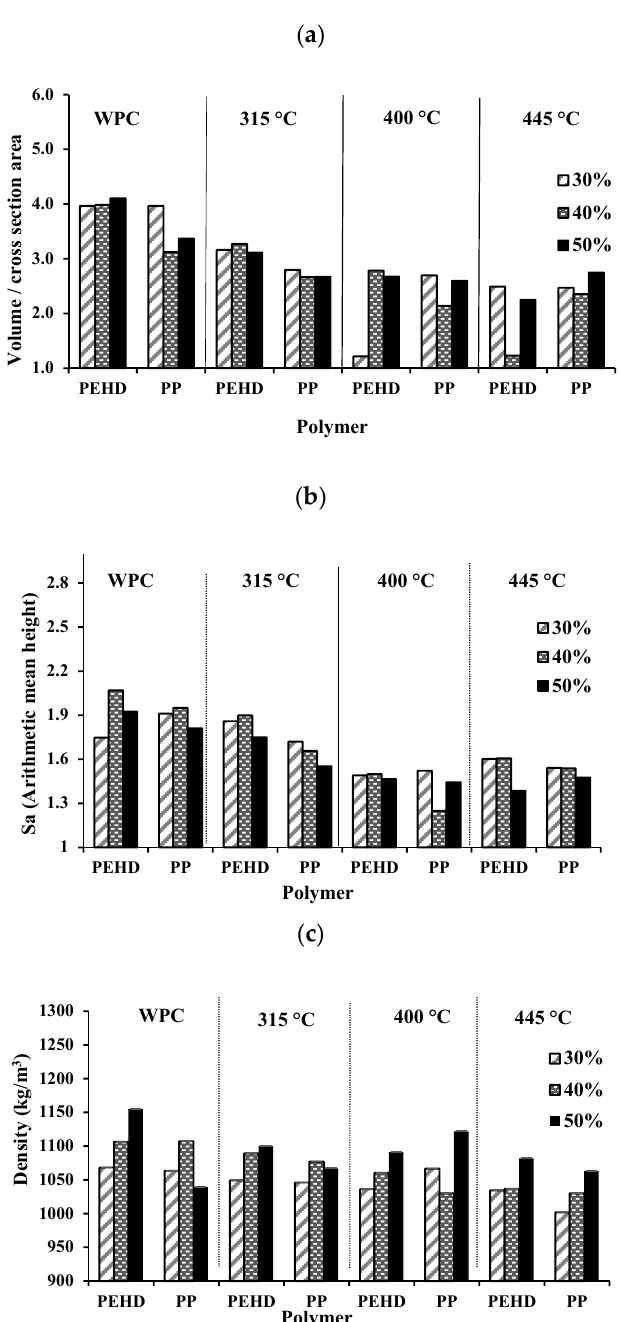
Figure7. Variationin: ( a )porosity(Volume / crosssectionarea; µ m), ( b )surfaceroughness(Sa:Arithmetic Figure 7. Variation in: ( a ) porosity (Volume/cross section area; μ m), ( b ) surface roughness (Sa: mean height; µ m) and ( c ) density (kg / m 3 ) of biocomposites made with wood and biochar at di ff erent Arithmetic mean height; μ m) and ( c ) density (kg/m 3 ) of biocomposites made with wood and biochar temperatures and in di ff erent at different temperatures and in different proportions. Table 4. Classification of materials surface roughness [38].